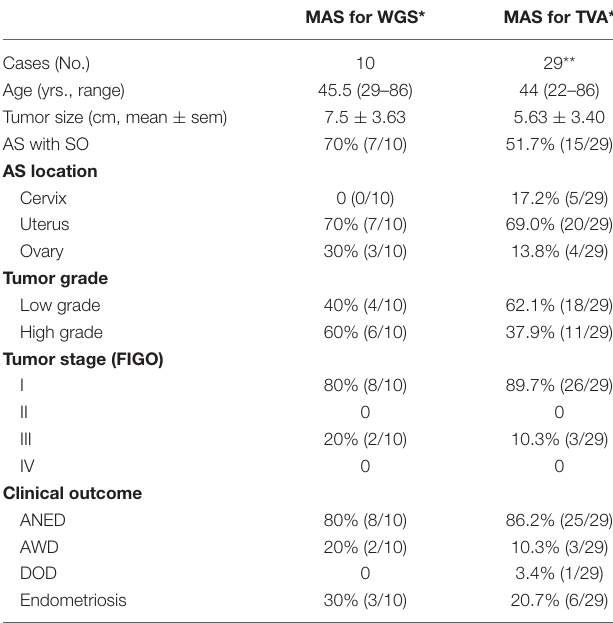
TABLE 1 | Pathology and clinical information of Müllerian adenosarcoma